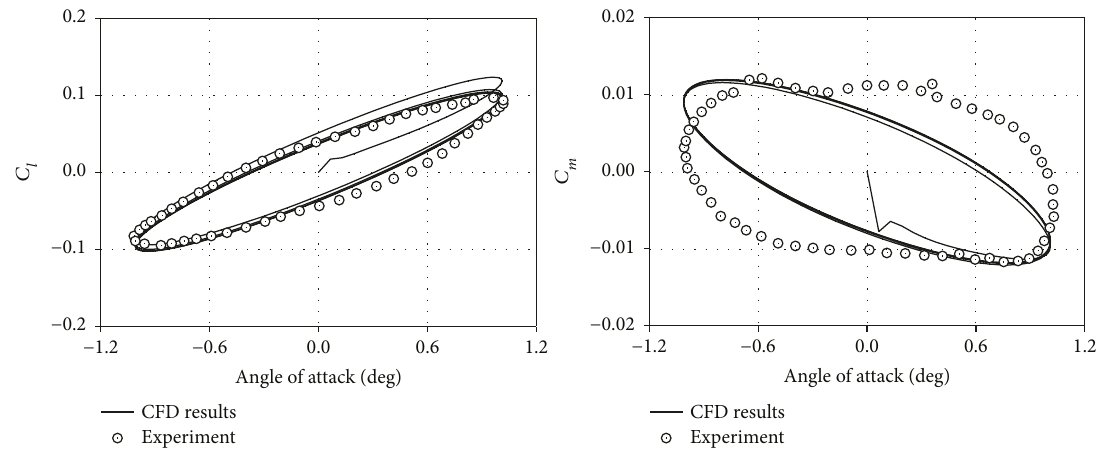
Figure 4: Lift and moment coe ffi cient loops for a NACA 64A010 airfoil at Mach number 0.796.